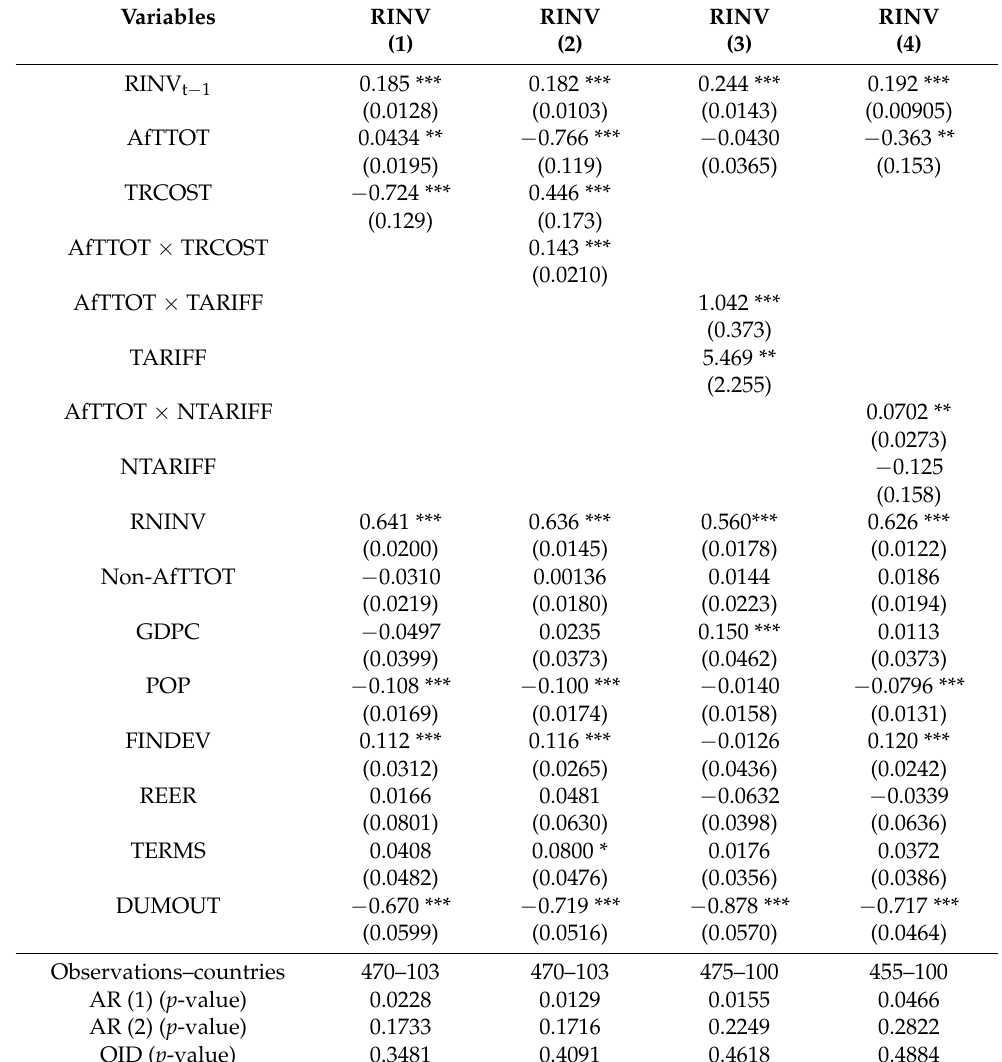
Table 5. Effect of AfT flows on investment-oriented remittance flows for varying levels of trade costs. Estimator: Two-step system